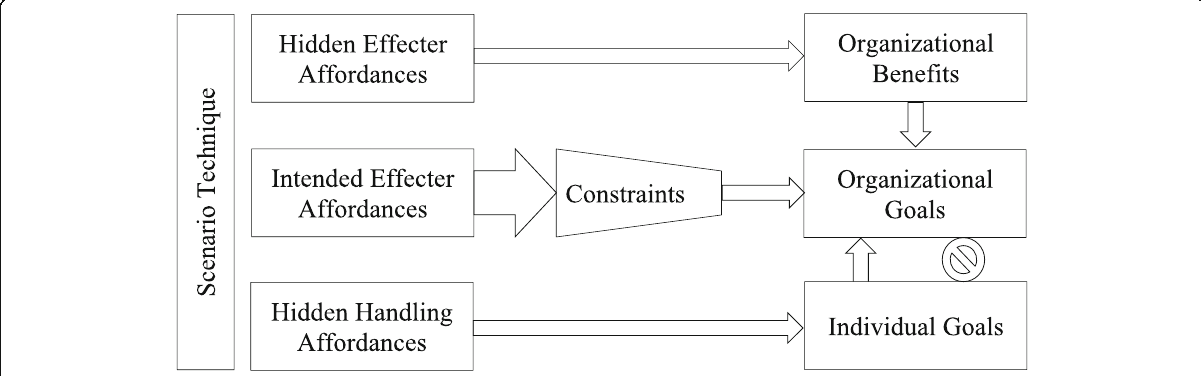
Fig. 2 Interrelationships between scenario planning affordances. Source: